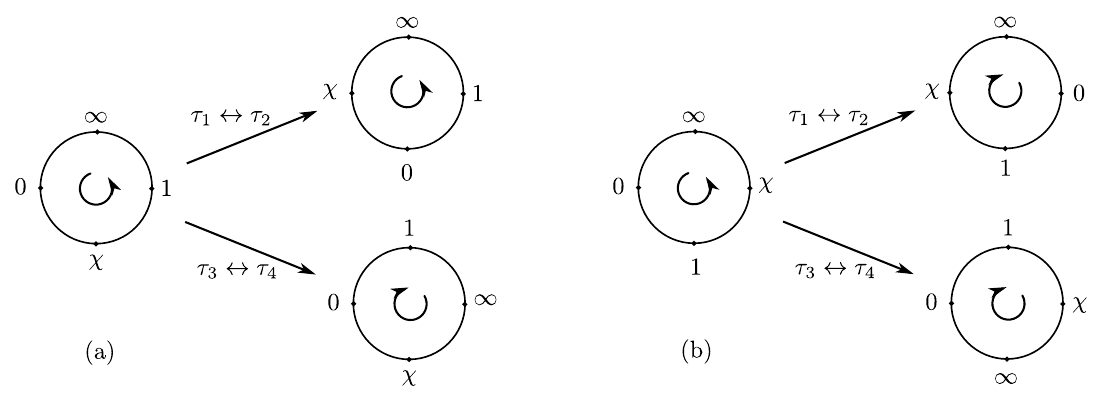
Figure 3 . The action of exchange of coordinates on (cid:31) for (a) 0 < (cid:31) < 1 and (b) (cid:31) > 1. We can see that exchange of coordinates can reverse orientation together with taking (cid:31) ! (cid:31)